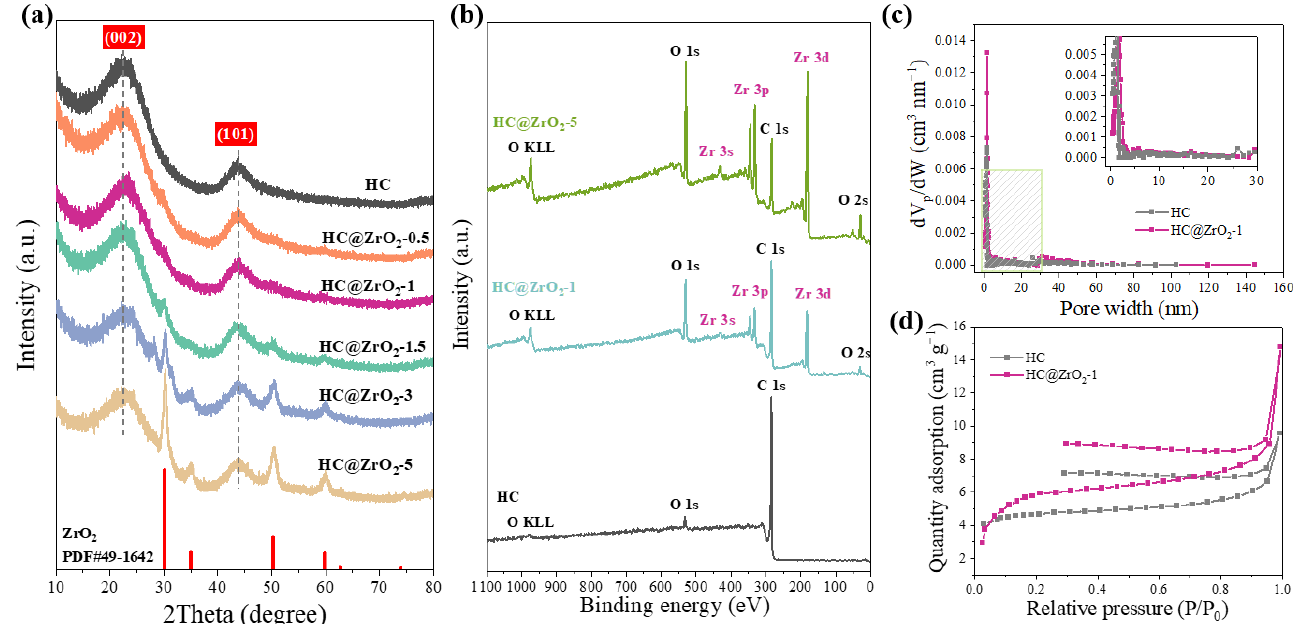
Figure 2. ( a ) XRD patterns of HC and HC@ZrO 2 . ( b ) XPS of HC, HC@ZrO 2 -1, and HC@ZrO 2 -5. ( c ) The density functional theory (DFT) pore size distribution of HC and HC@ZrO 2 -1. ( d ) N 2 adsorp- tion-desorption measurements of HC and HC@ZrO 2 -1.